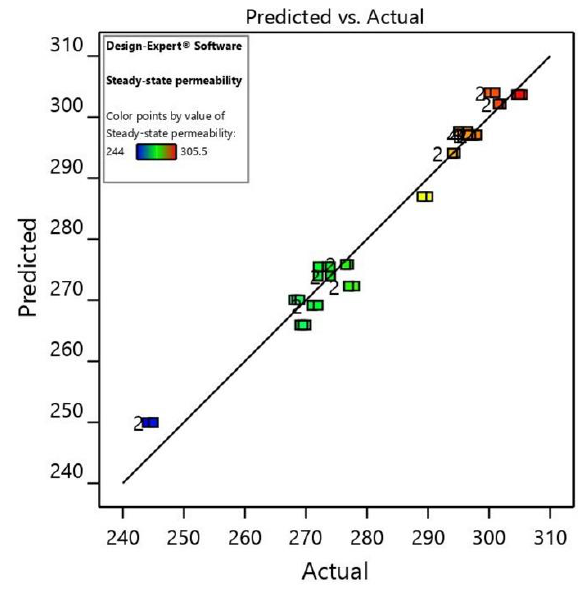
Figure 3. Design-Expert plot of predicted vs. actual values plot for permeability.